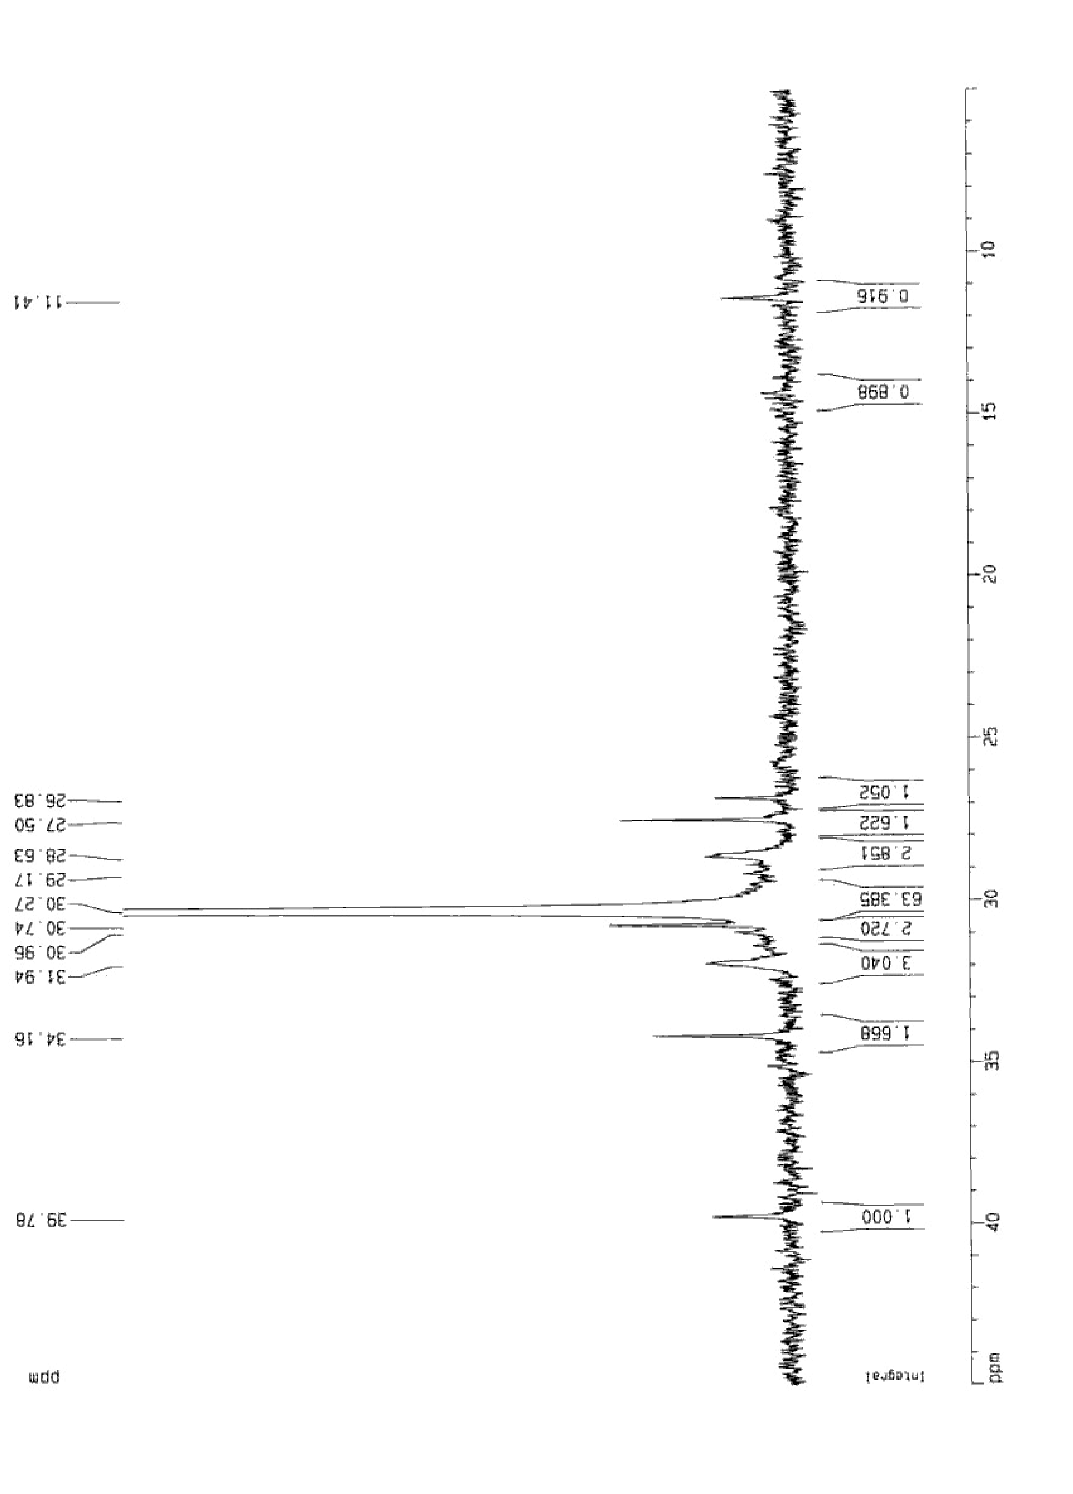
Fig. 4 13 C-NMR result of polyethylene (Entry